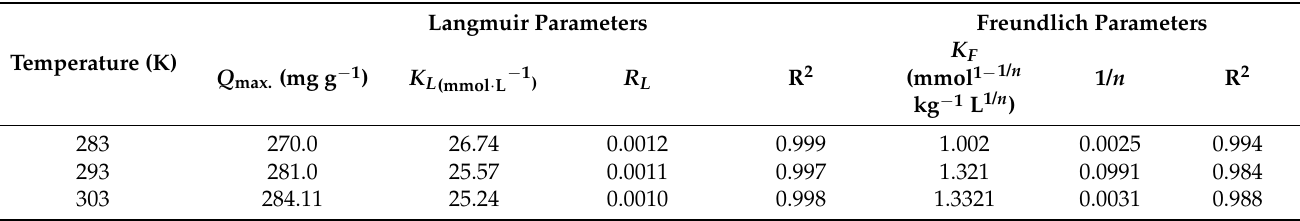
Table 2. Langmuir and Freundlich parameters along with correlation coefficients for the adsorption of Cd (II) ion onto AC at pH 6.